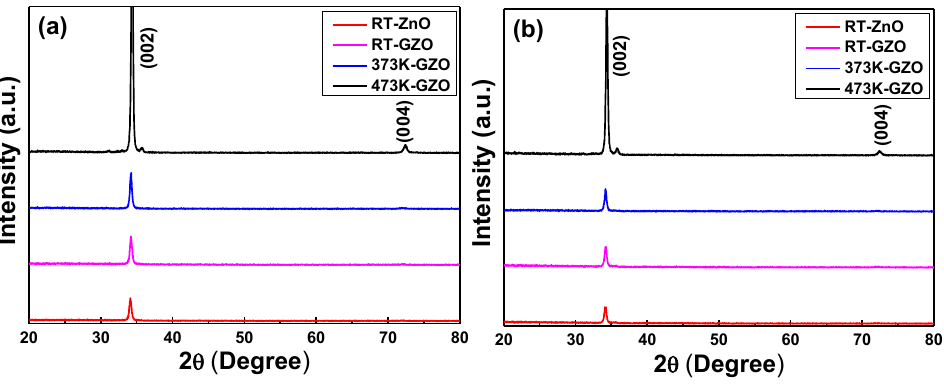
Figure 3. X-ray diffraction (XRD) patterns of the undoped ZnO thin films and GZO thin films as a function of deposition temperature and on different substrates: ( a ) glass and ( b ) PI. a.u.: arbitrary unit.